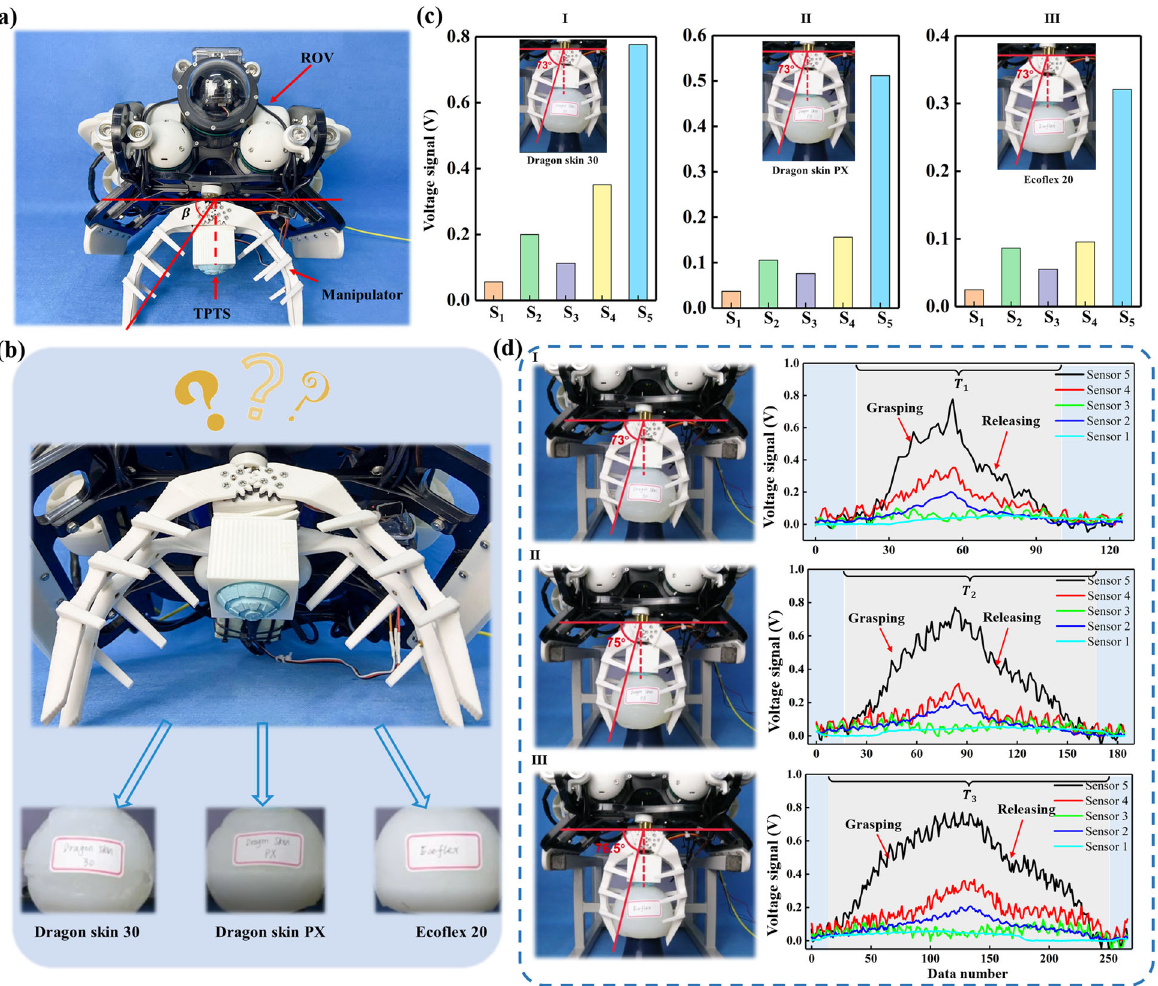
Fig. 6 Experiments with TPTS mounted on an ROV. a , b The con fi guration of the gripper and sensors for detecting the hardness of a silicone sample. c The output signals of the TPTS when gripping various silicone samples under the condition of β = 73 ∘ . d Demonstration of the TPTS in a closed-loop control system for an ROV and the corresponding output voltage